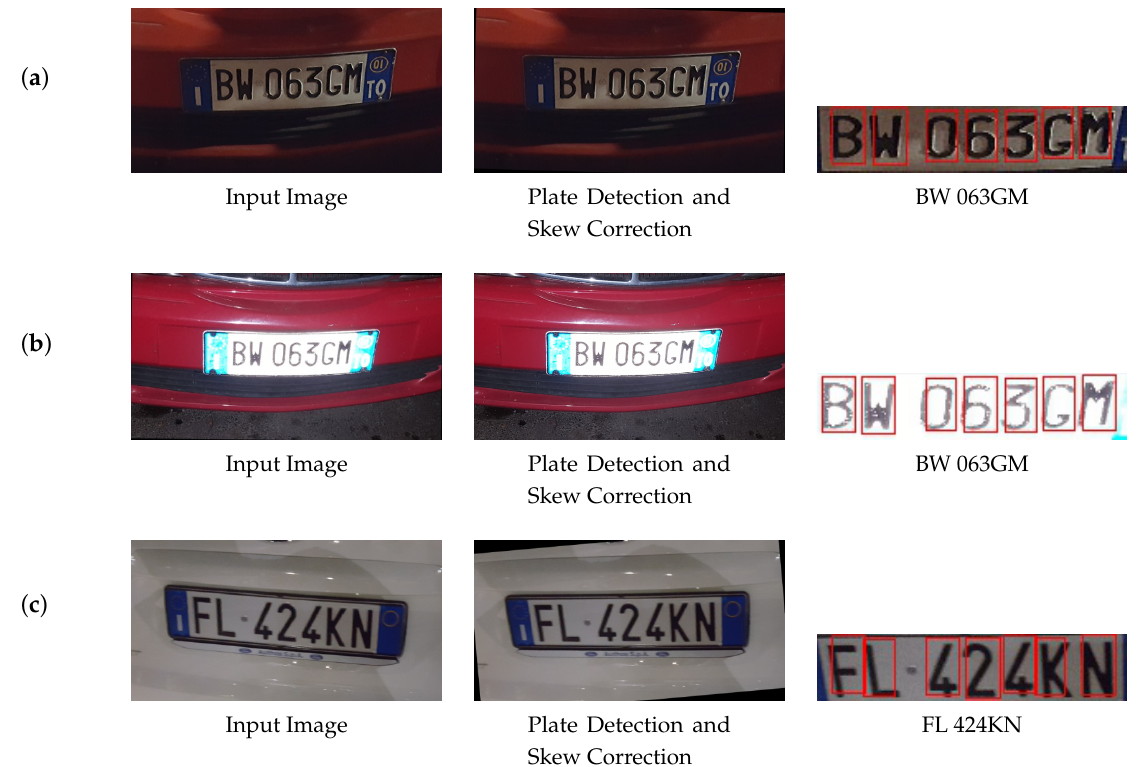
Figure 5. Examples of different challenging imaging conditions: ( a ) image captured at night with insufficient illumination; ( b ) image captured at night with over-exposure and reflections due to speedlight; ( c ) image captured at night and with perspective